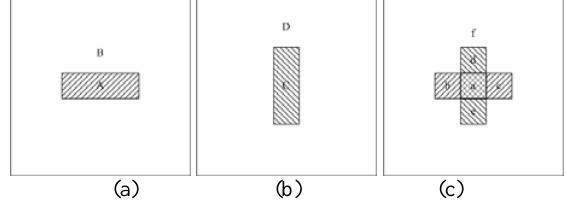
Figure.1 Diagram of Synthesis Method Combining Integrated Segmentation and Independent Segmentation, (a) Diagram of Phase 1.(b) Diagram of Phase 2.(c) Diagram of Integrated Segmentation of Phase 1 and Phase 2. Shape of the object - a in Figure. 1 (c) is a static shape